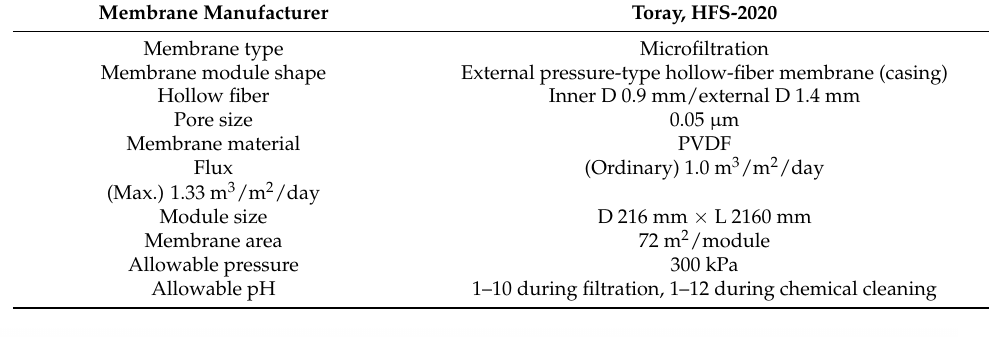
Table 1. Membrane module specifications.